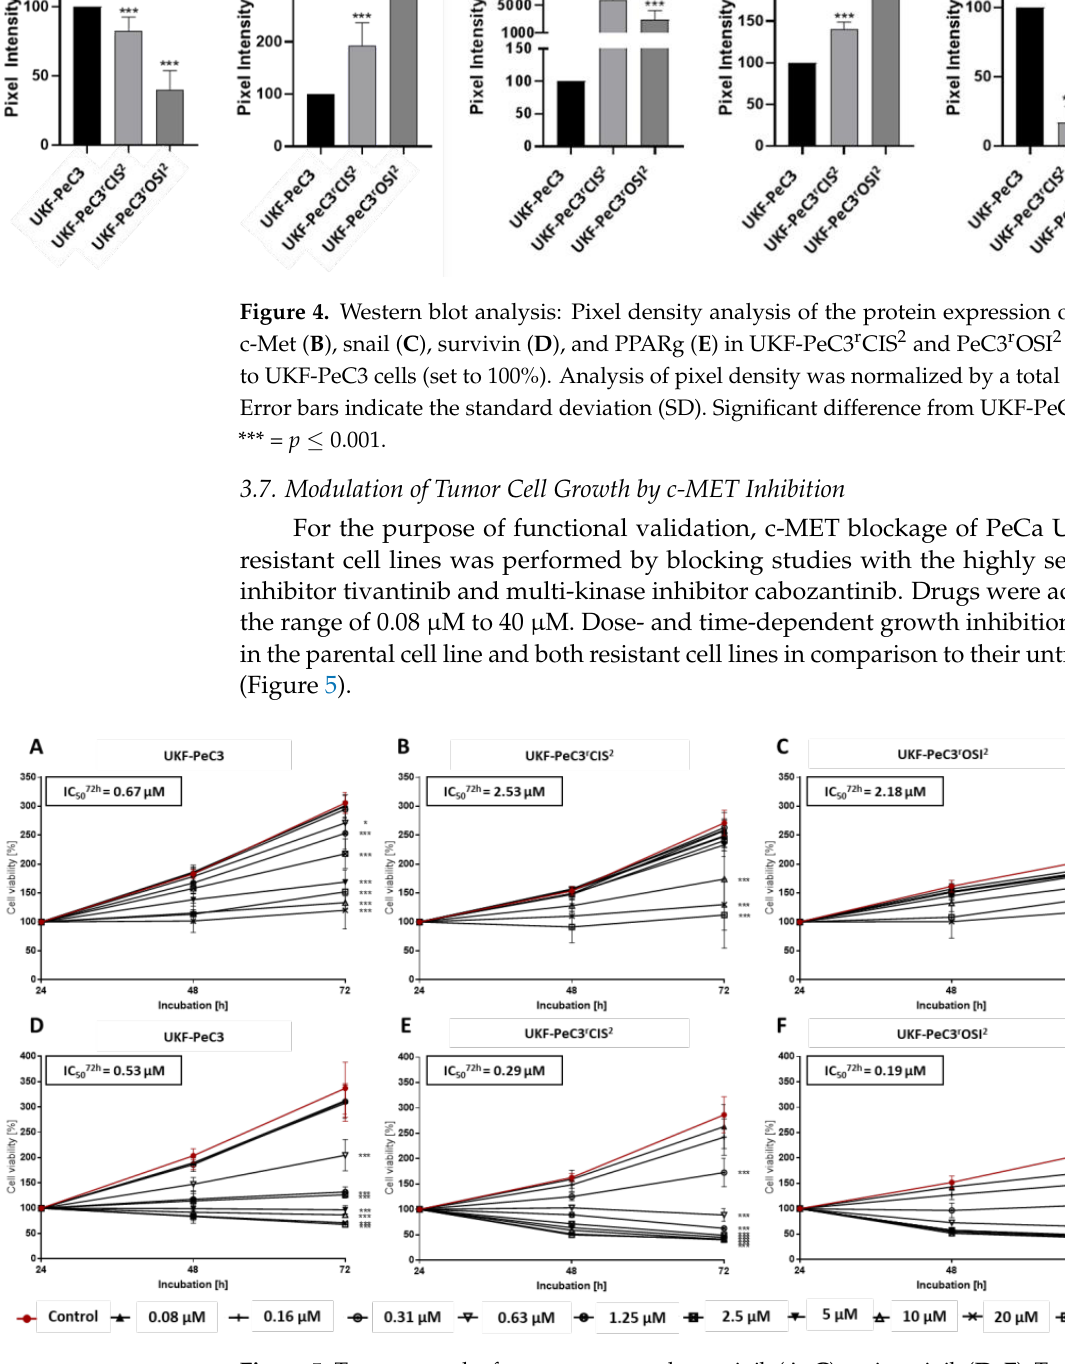
Figure 5. Tumor growth after exposure to cabozantinib ( A – C ) or tivantinib ( D – F ): Tumor cell